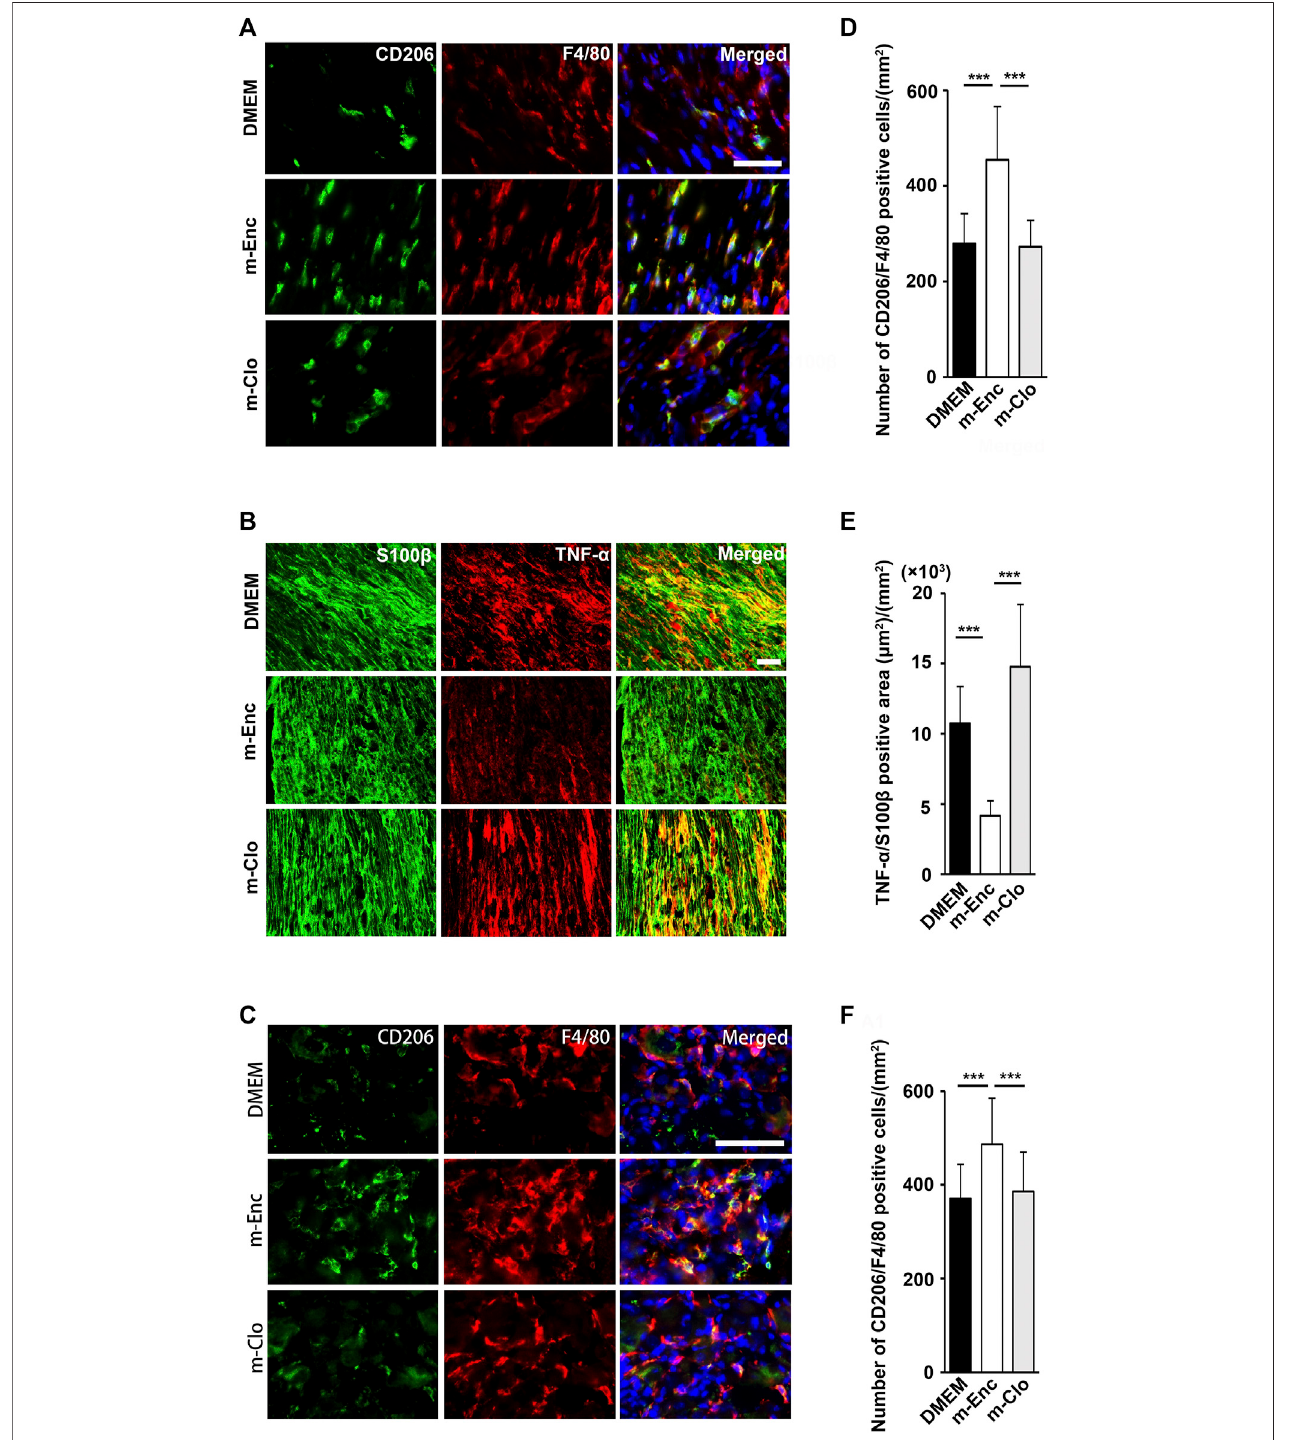
FIGURE 6 | Effects of depletion of SHED-CM-induced M2 on the activation of Schwann cells. (A) Representative images of immuno fl uorescent staining of (A) CD206, F4/80 and (B) TNF- α , S100 β in SCN, and (C) CD206, F4/80 in L4/5 DRG 7 days after PSL. Scale bar: 50 μ m in (A,B,C) . (D – F) Quanti fi cation analysis of (D) CD206 + F4/80 + cell numbers and (E) TNF- α + S100 β + area in SCN, and (F) CD206 + F4/80 + cell numbers in L4/5 DRG. Tukey multiple comparisons of means ( n = 8 – 10, per group). Data represent the mean ± SD. *** p < 0.001.